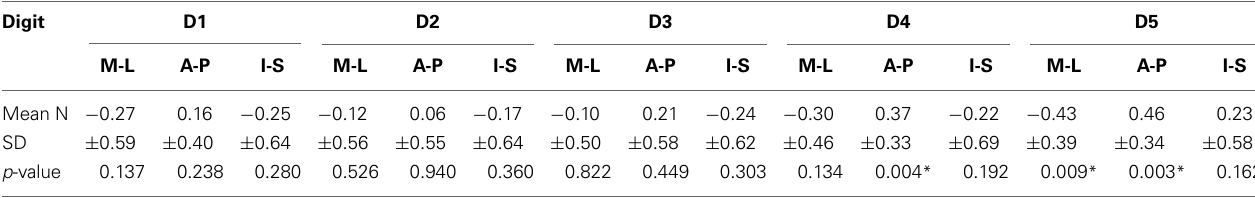
Mean N vectors (calculated across the p1 to p3 peak vertices), respective coordinates and standard deviations (SD), and p-values for digits D1 to D5 along the medial-lateral (M-L), anterior-posterior (A-P), and inferior-superior (I-S) ACPC axis, respectively. * p = 0.0167 (i.e., p ≤ 0.05 corrected for the three comparisons along the three